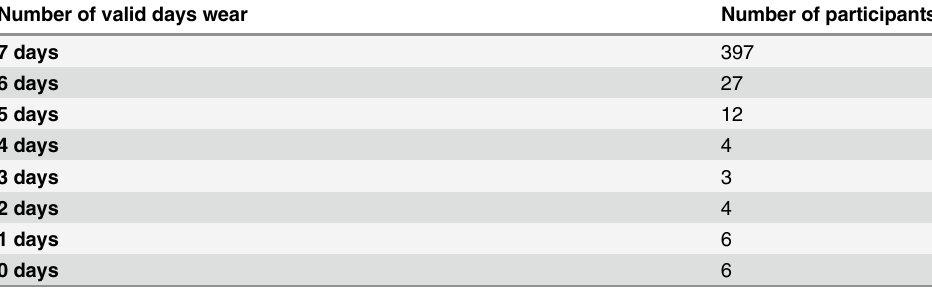
Table 2. Number of participants with valid days ( > 10 hours of wear time) of